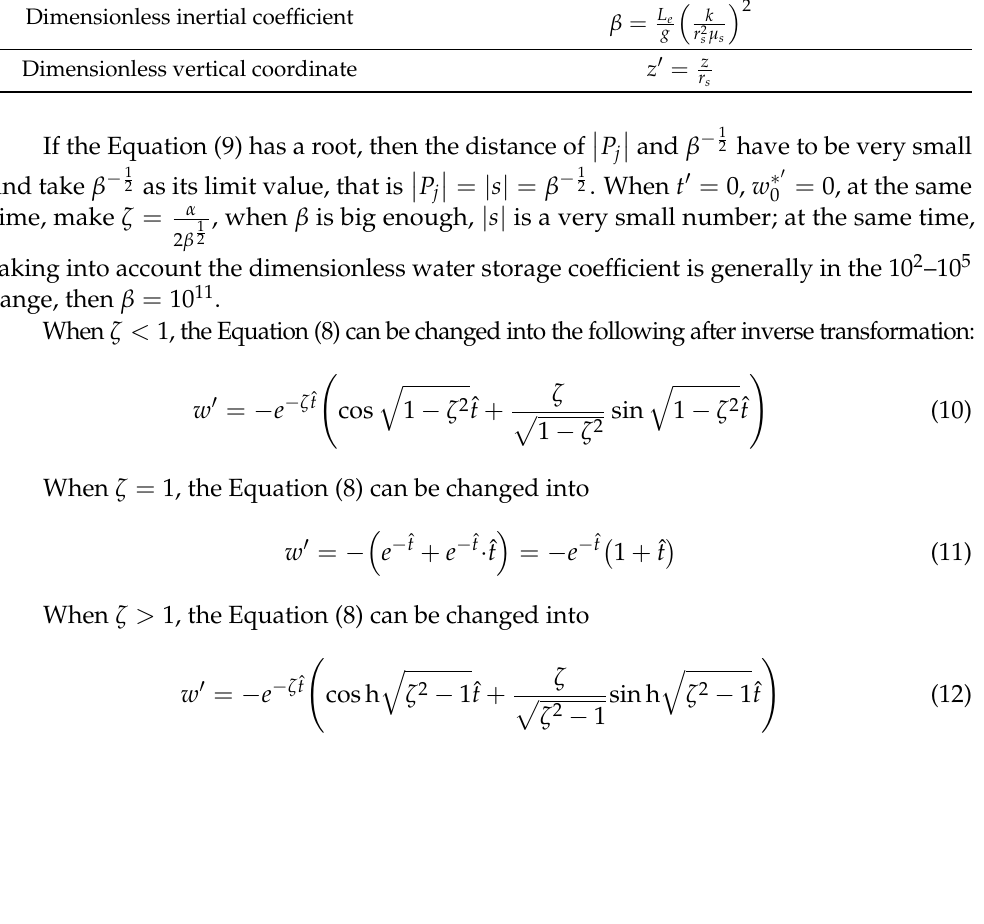
Table 1. Parameter dimensionless transformation. Dimensionless Variable Dimensionless Transformation Dimensionless water level variable w (cid:48) = − w Dimensionless water level Dimensionless time Dimensionless radius r (cid:48) = r Dimensionless storage coefficient Dimensionless inertial coefficient Dimensionless vertical coordinate z (cid:48) = z